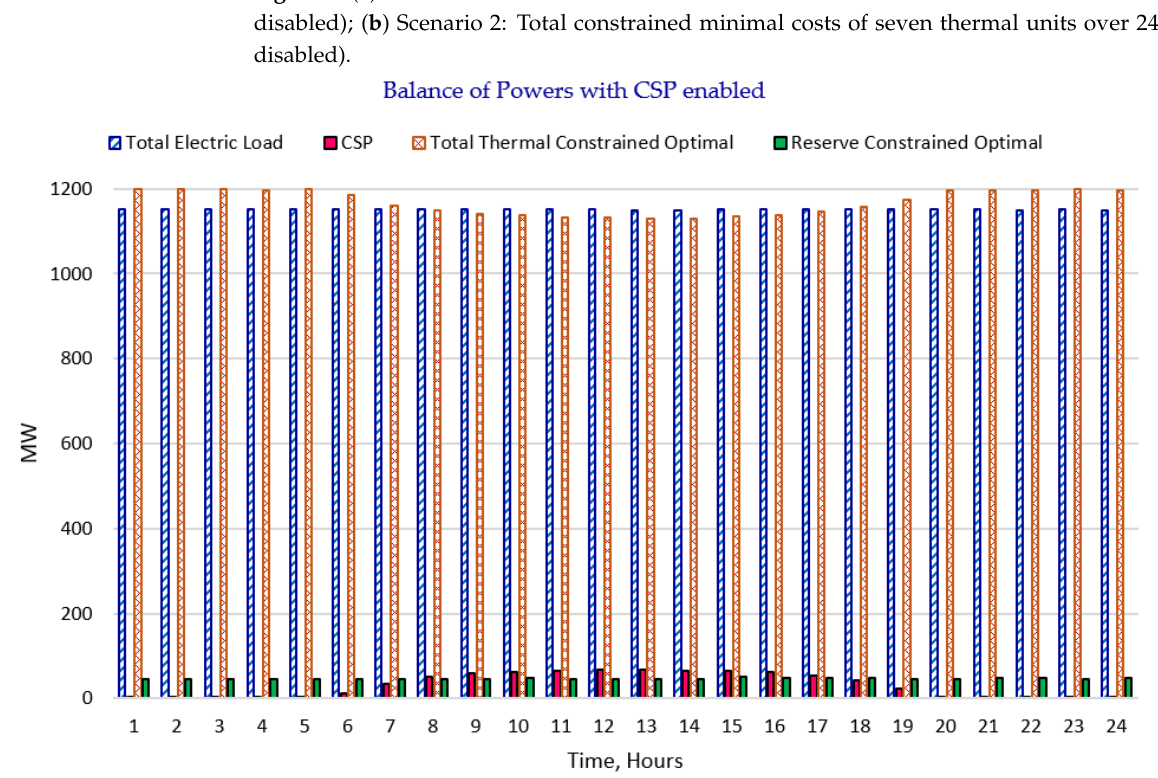
Figure 8. Scenario 1: The balance of generated powers of optimally constrained hybrid thermosolar system, of generated reserves, with total varying electrical load, during 24 h (CSP enabled). In Figure 9 is the balance of powers for the two scenarios: in Scenario 1, hybrid thermosolar with CSP enabled and in Scenario 2, thermal with CSP